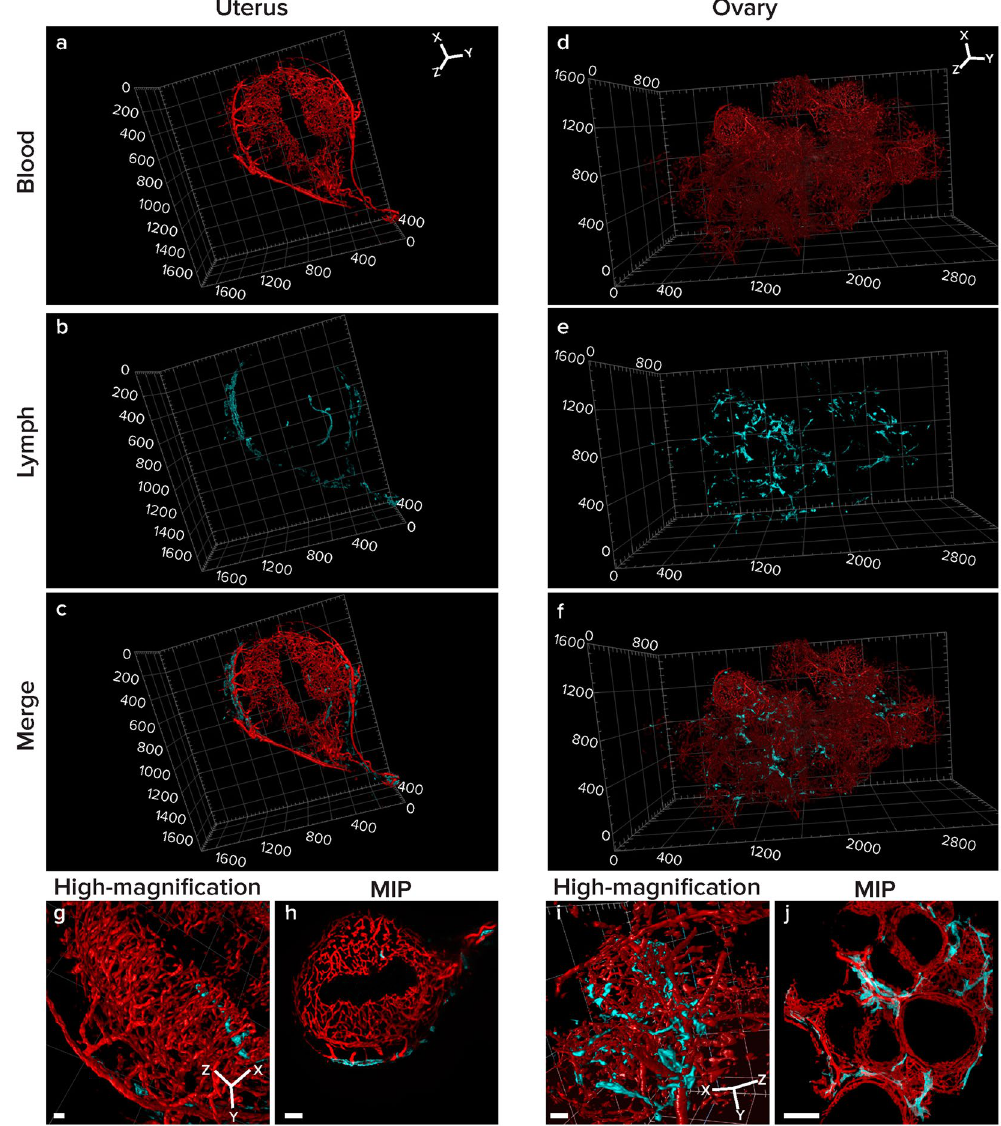
Figure 3. Three-dimensional reconstruction and MIP of slabs of uterus and ovary. Uteri and ovaries were harvested from Vecad cre /tdTomato flox/stop/flox transgenic mice (blood vessels, red channel) and were labeled with LYVE1 antibody (lymphatic vessels, cyan channel). Organs were cleared and imaged using a light-sheet fluorescent microscope. Tiles were stitched (10% overlap for stitching) creating large field of view stacks. Data sets of uterus ( a – c ) and ovary ( d – f ) are presented as 3D volumes. Maximal intensity projections (MIP) of slabs (Uterus: 33 slices/53.46 µ m, ovary: 87 slices/140.94 µ m) show the uterine spiral arteries, endometrium and myometrium as well as the ovarian follicles surrounded by capillaries. High-magnification of rotated images ( g , i ) show the continuity of blood and lymphatic vessels. Scale bar: MIPs - uterus 100 µ m, ovary 200 µ m;